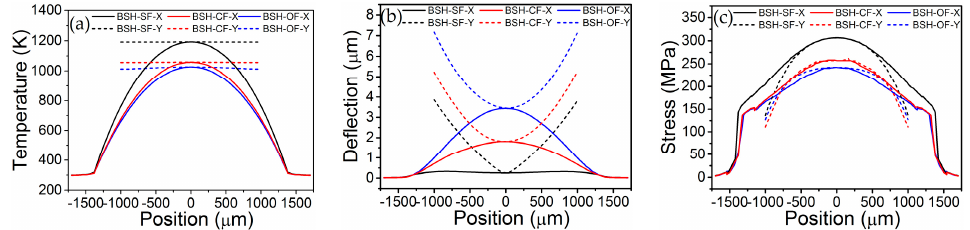
Figure 3. Dependence of temperature ( a ); deflection ( b ); and stress ( c ) on hotplate position along x and y directions in hotplate center of BSH-SF, BSH-CF, and BSH-OF emitters under work voltage of 12 V.